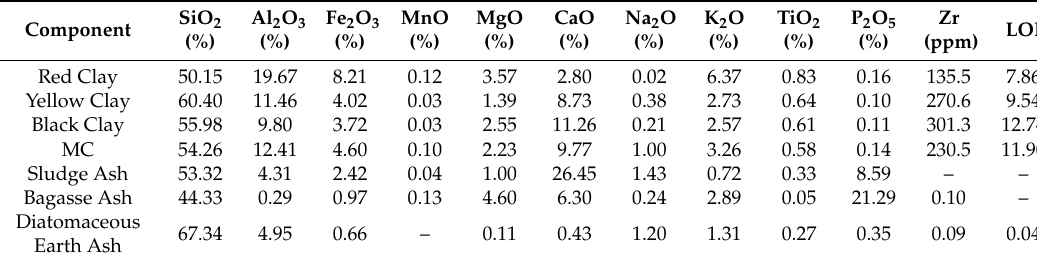
Table 1. Chemical composition of the clay and waste ash.